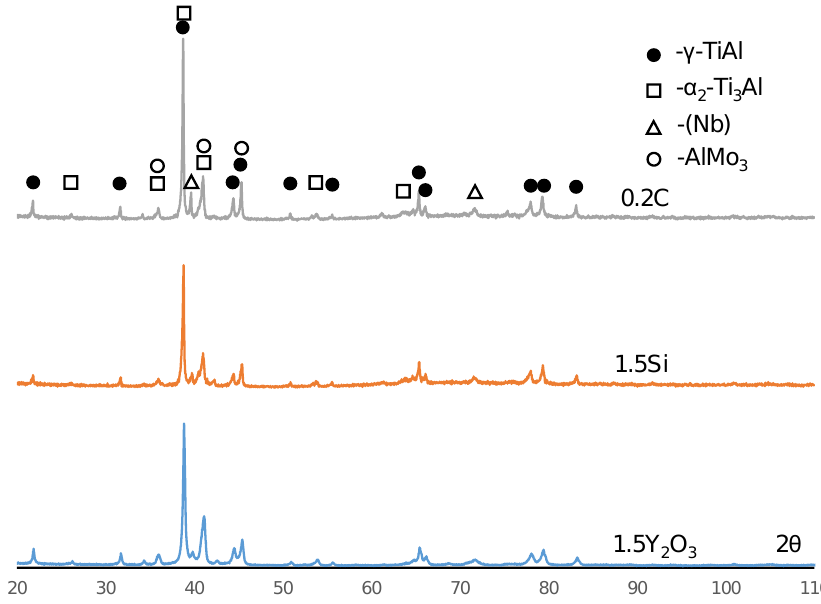
Figure 3. The XRD patterns of the as-HIP-ed alloys 0.2C, 1.5Si, and 1.5Y 2 O 3 . Table 1. The phase composition of the HIP-ed alloys 0.2C, 1.5Si, and 1.5Y 2 O 3.